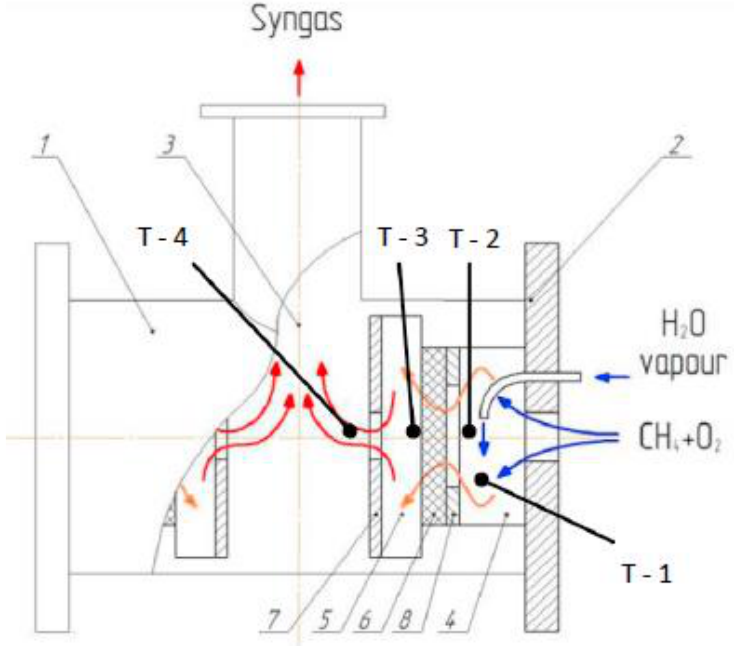
Figure 7. The principle of operation of the converter with a permeable matrix: 1—core vessel;